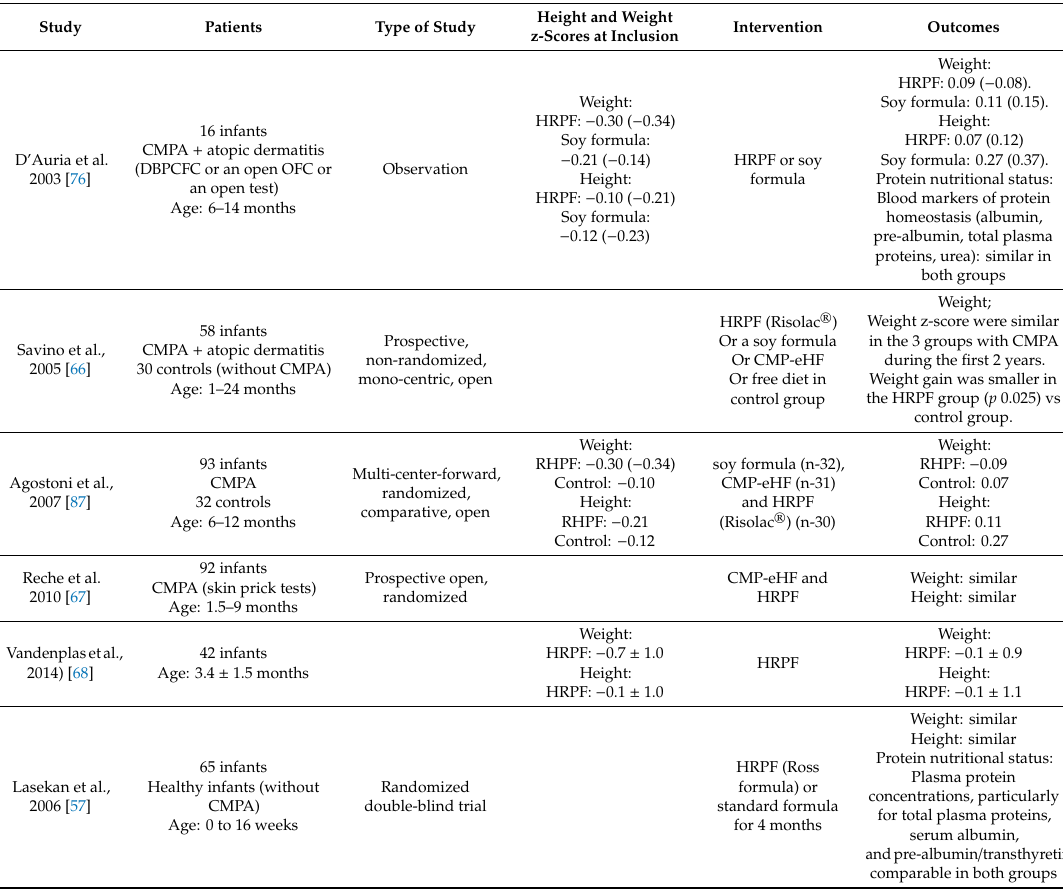
Table 6. Growth and weight evolution and protein nutritional status in children a ff ected with CPMA or healthy children (one